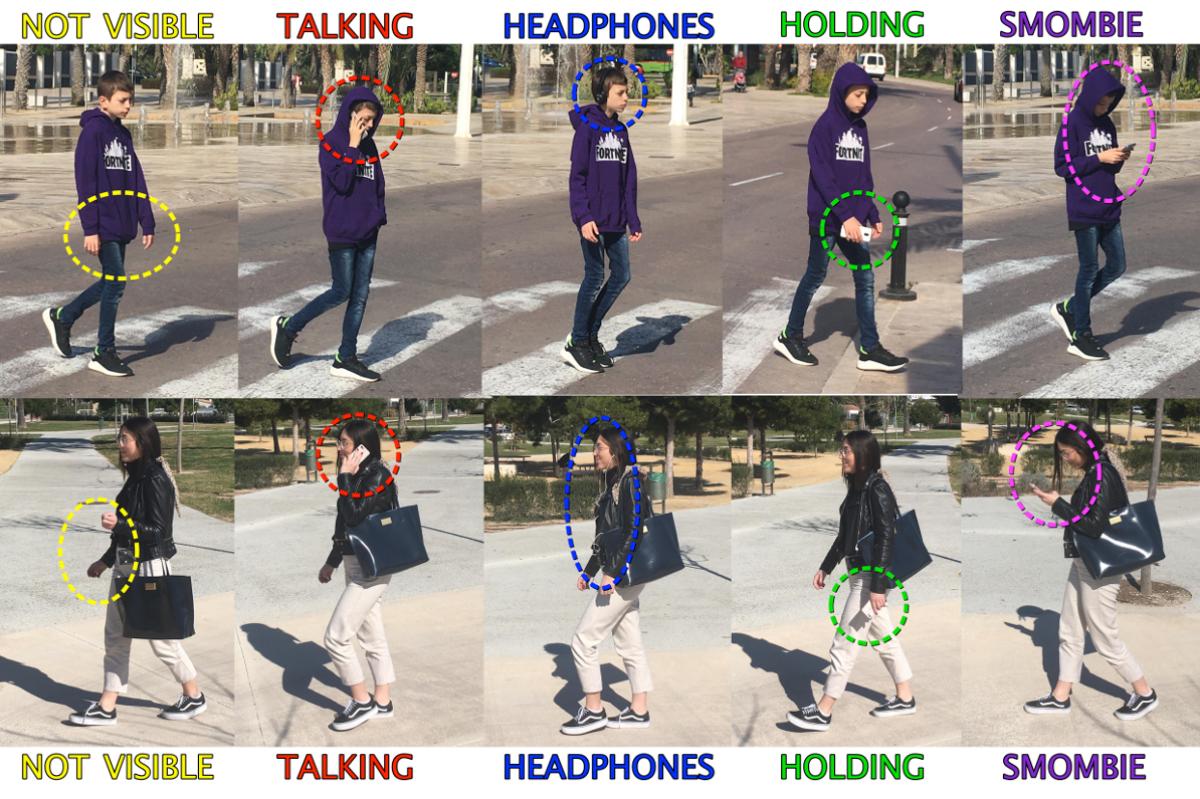
Figure 1. The 5 types of smartphone usage behaviors observed in street pedestrians. From left to right (lower to higher use of smartphone): smartphone "not visible," "talking" on a smartphone, using "headphones," "holding" a smartphone, and